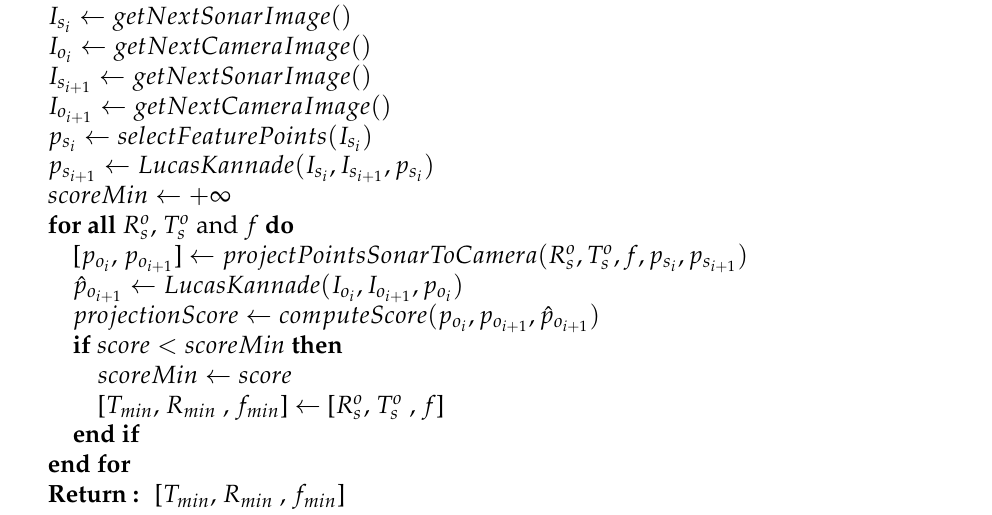
Algorithm 1 Research of the calibration algorithm on one set of camera and sonar image